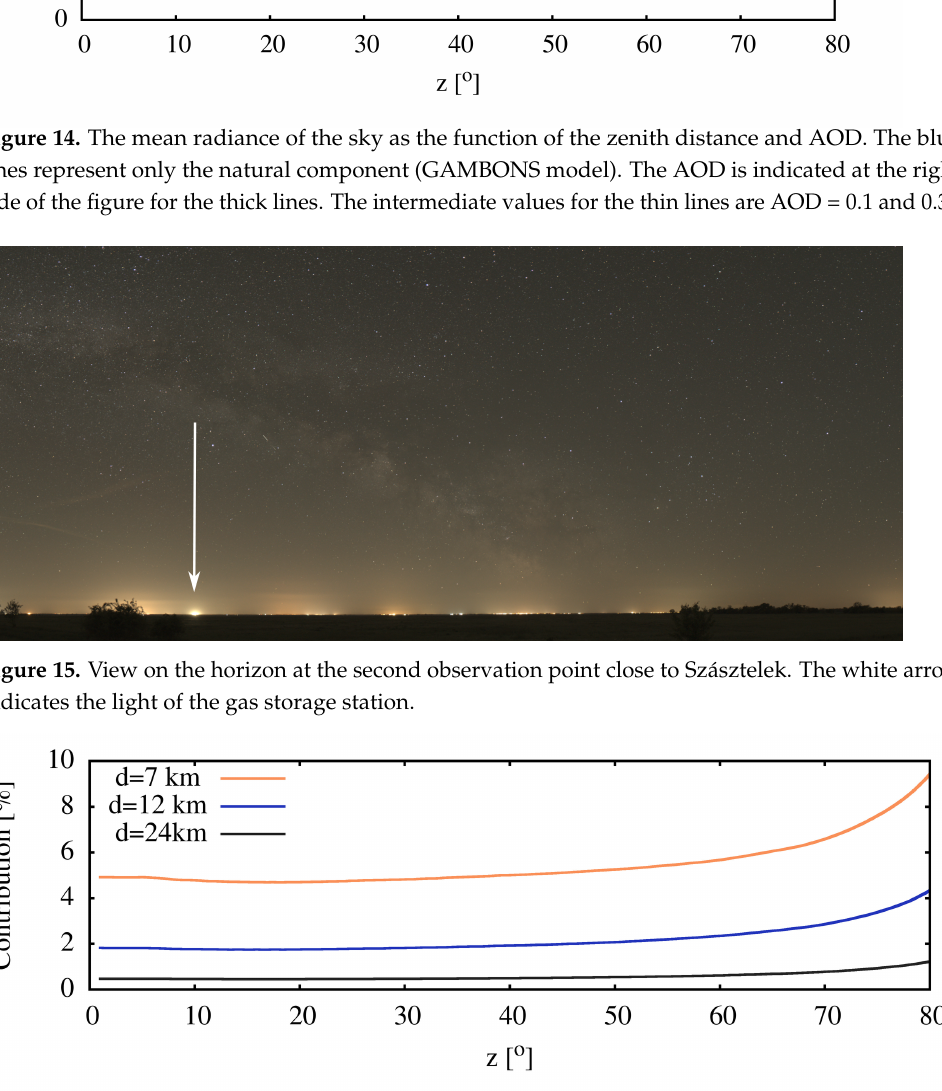
Figure 16. The relative contribution of the gas storage facility to the sky radiance compared to the natural sky from three different